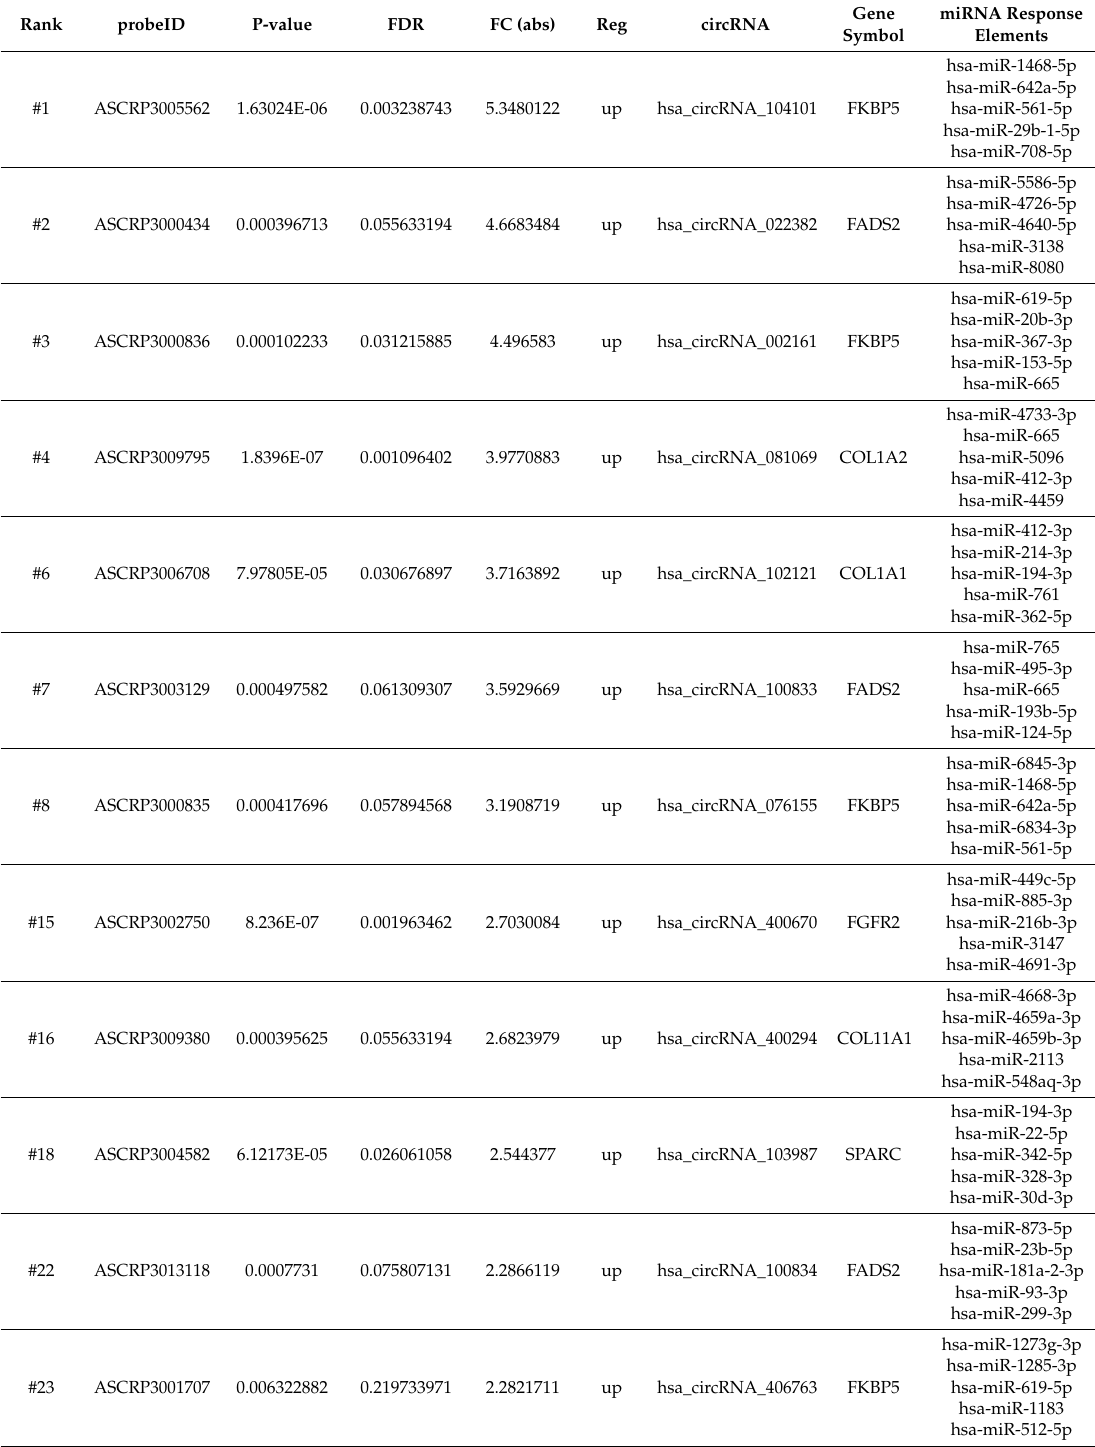
Table 2. Selection of di ff erentially expressed circRNA in chondrogenic di ff erentiation. CircRNAs are sorted and ranked by fold change. The results of hybridization arrays identified 130 upregulated and 197 downregulated circular RNAs in osteogenic di ff erentiation vs. undi ff erentiated control. The full table, including all the di ff erentially expressed circRNA in chondrogenic di ff erentiation, is available in the supplementary file (Table